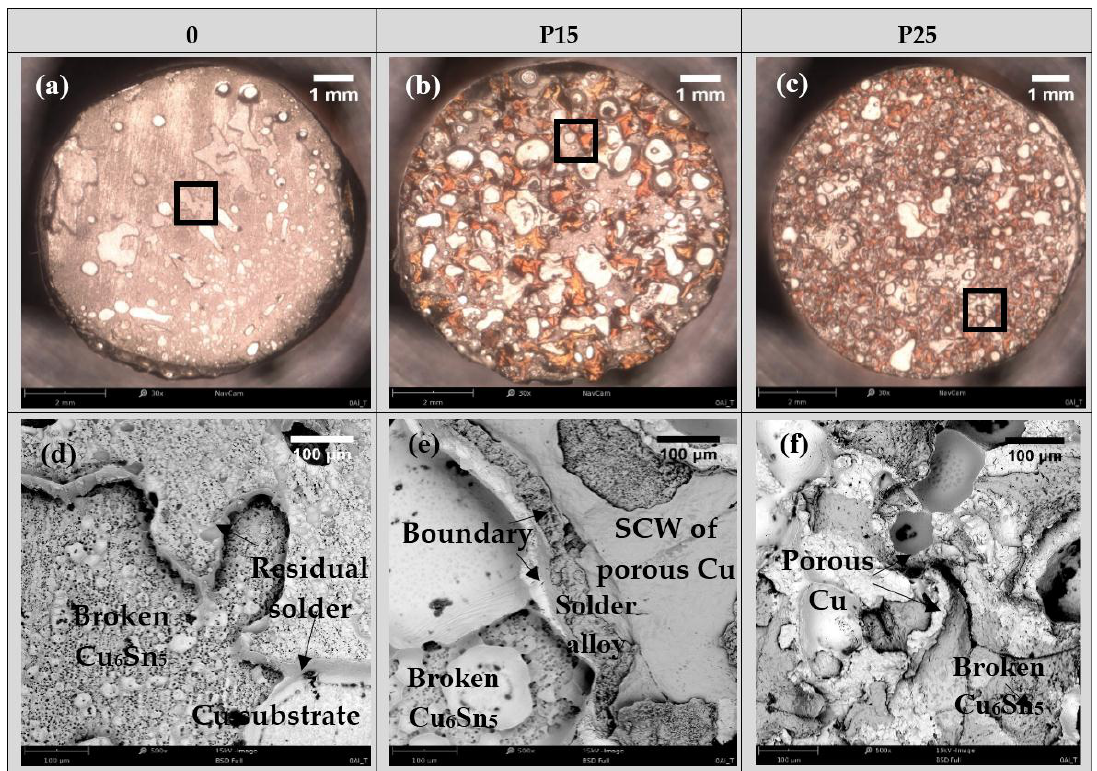
Figure 8. Fracture morphology of solder joint at soldering temperature of 307 °C with soldering time of 300 s; ( a – c ) optical microscope; ( d – f ) high magnification from